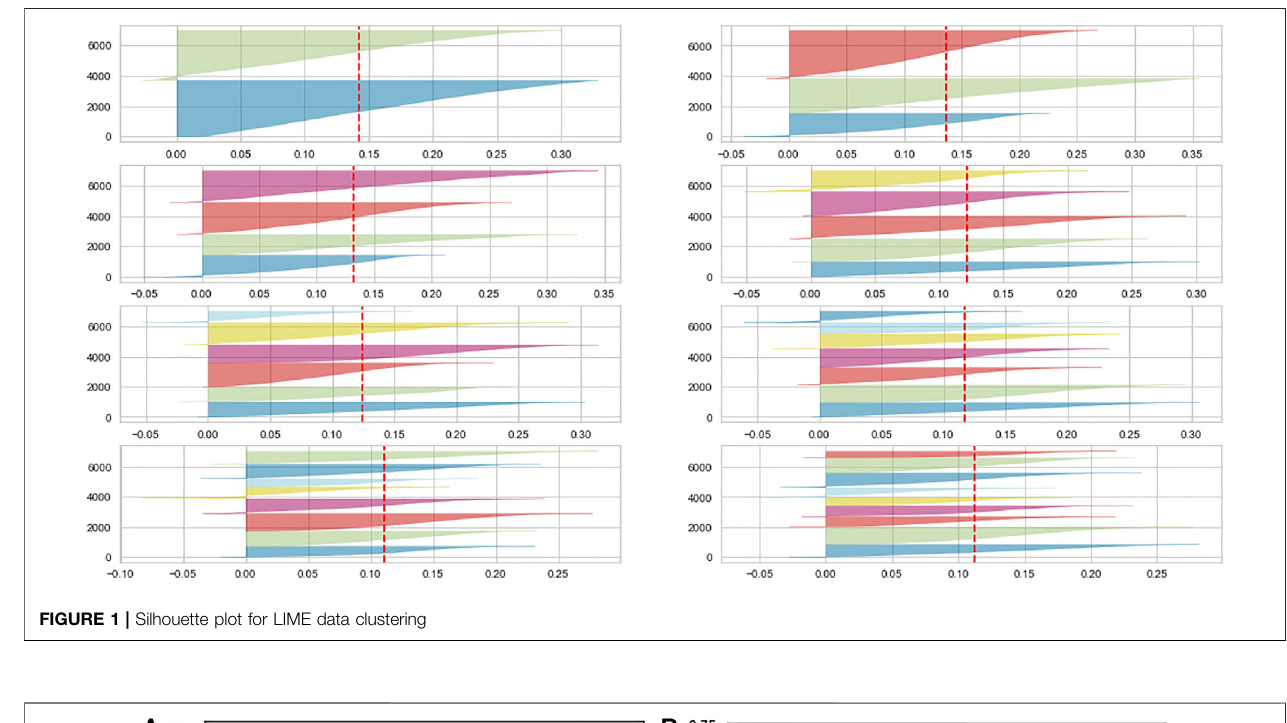
FIGURE 1 | Silhouette plot for LIME data clustering